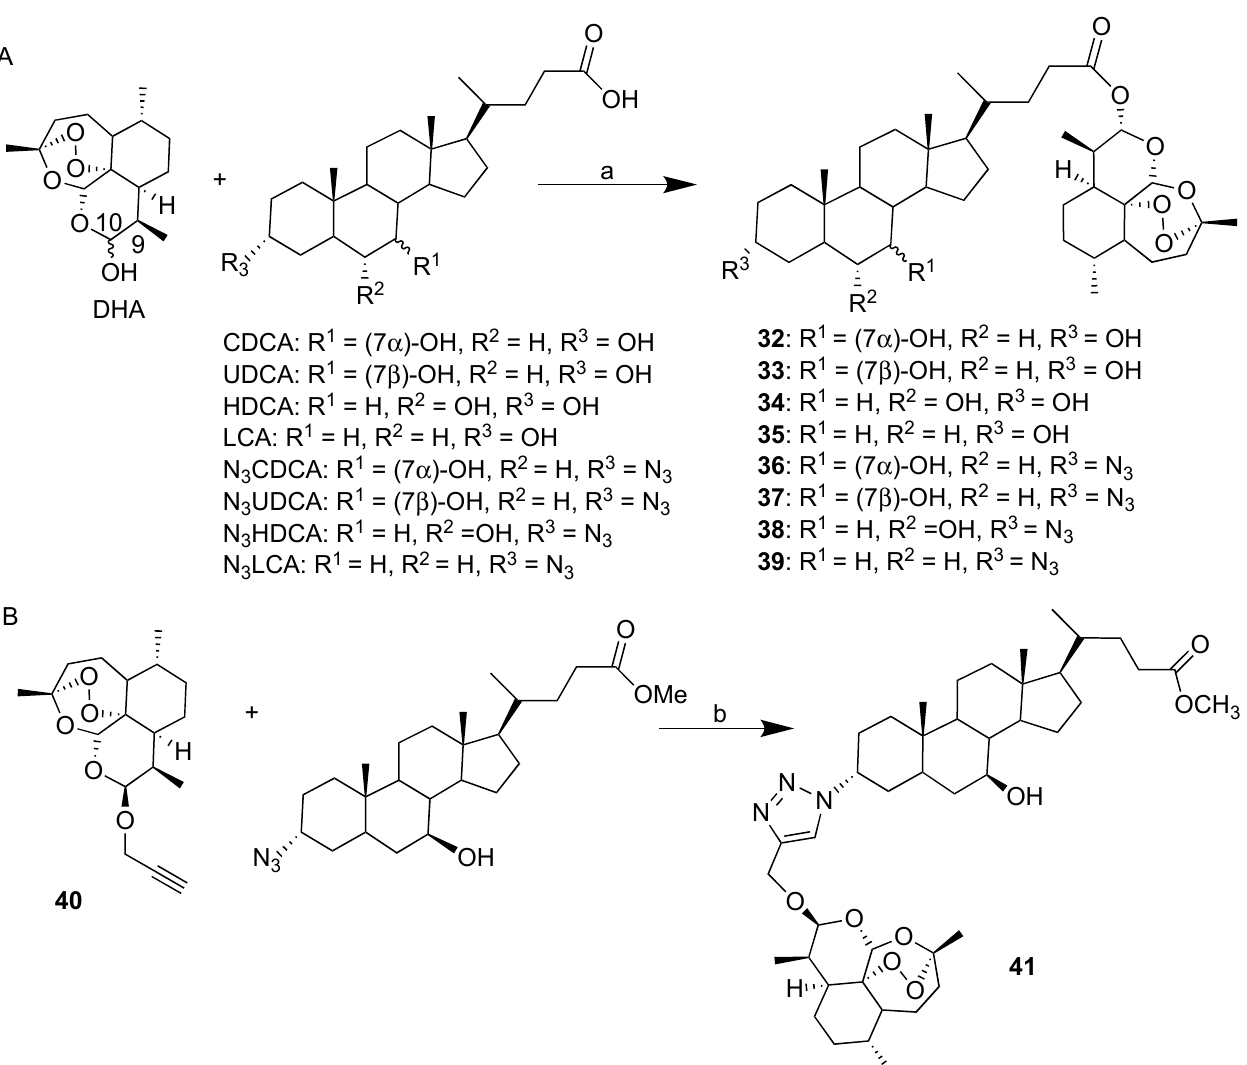
Scheme 3. ( A ) Synthesis of BA-DHA hybrids trough condensation reaction. Reaction conditions: (a) EDCI, DMAP, DMF, 25 ◦ C, 18 h, 25–60% yield; ( B ) Synthesis of UDC-DHA hybrid 41 via click chemistry. Reaction conditions: (b) propargyl- DHA/N 3 UDCMe ratio: 1/1, CuI 0.1 eq, room temperature, 18 h, 28%